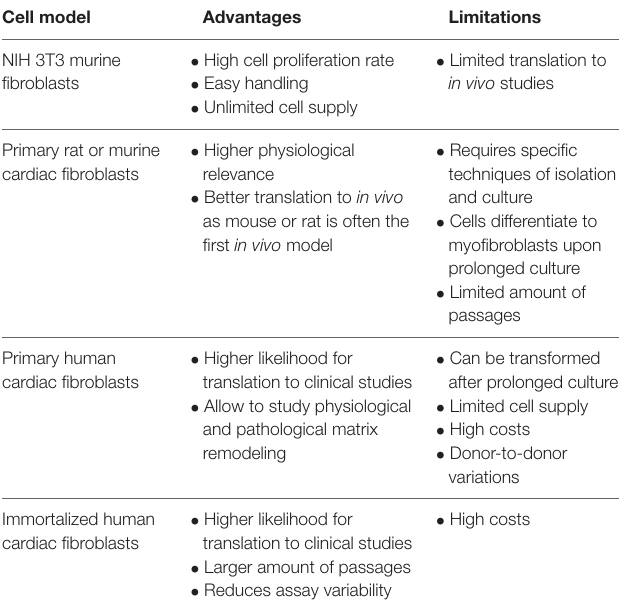
TABLE 2 | Cell models used in in vitro cardiac fibrosis